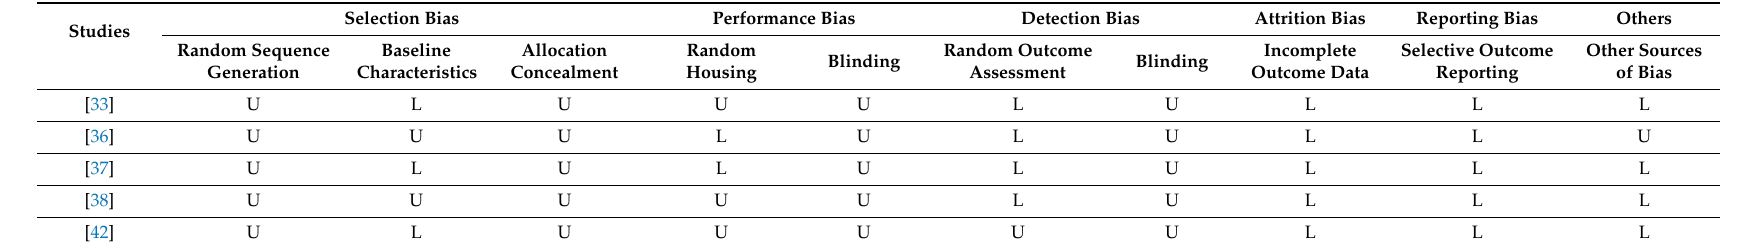
Table 3. Risk of bias assessment for in-vivo studies using SYRCLE’s